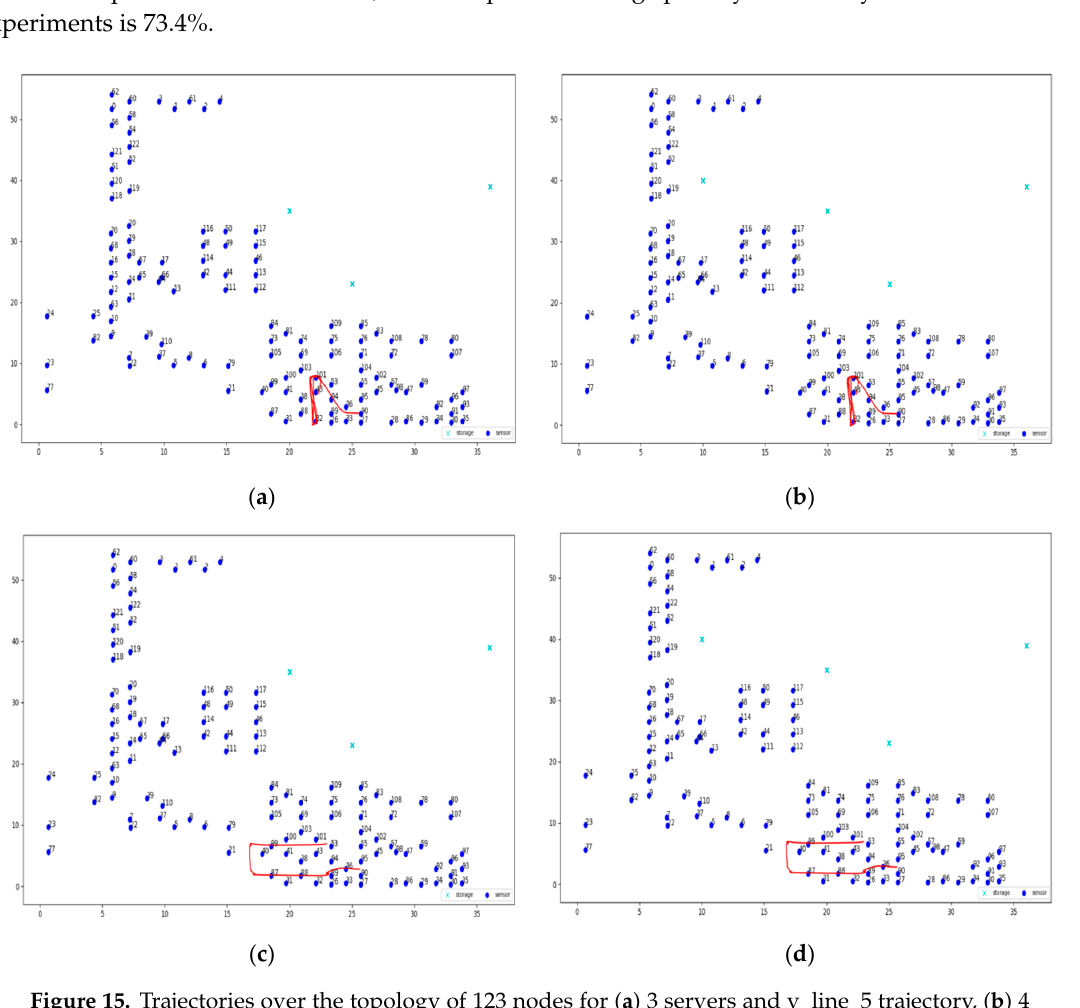
Figure 15. Trajectories over the topology of 123 nodes for ( a ) 3 servers and v_line_5 trajectory, ( b ) 4 servers and v_line_5, ( c ) 3 servers and square_1 trajectory, ( d ) 4 servers and square_1 trajectory.